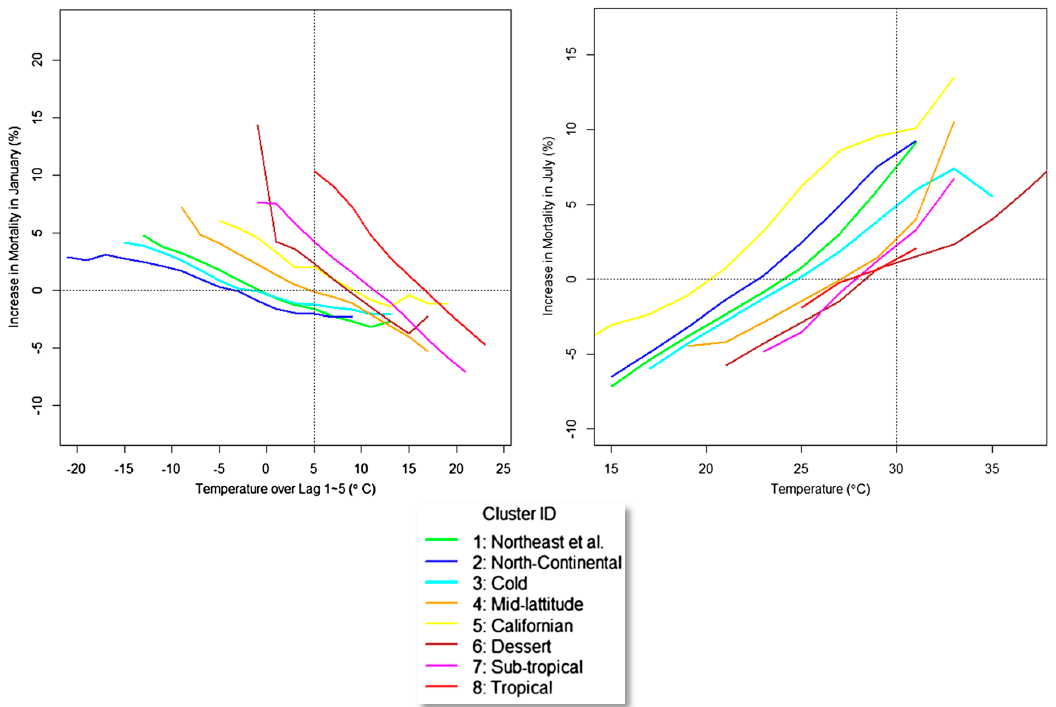
Figure 2. From Lee et al., 2014 [17]. Temperature-mortality risk functions by US region. At ( left ) is effect of temperature on mortality in January. At ( right ) is effect of temperature on mortality in July. Between 8–36 cities are included in each region, with effects summarized using meta regression.